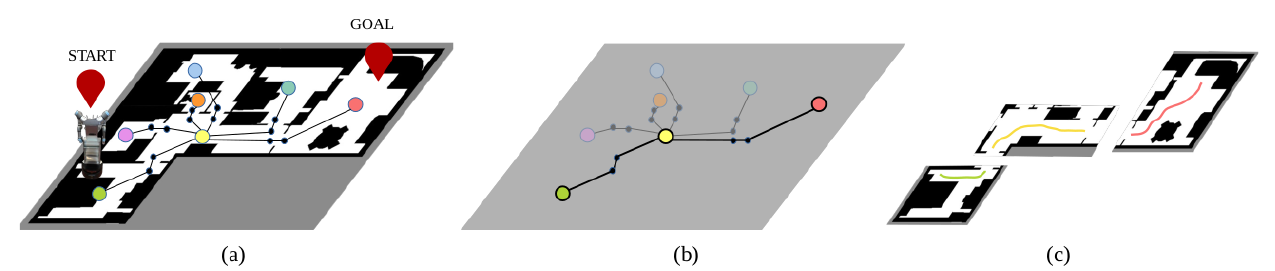
Figure 5. Planning steps: ( a ) initial scenario representation, where red signs indicate the starting and goal positions, ( b ) global topological plan (highlighted part of the map), and ( c ) local geometric plans. The same colors are used on the topological and geometric plans to indicate the relation among